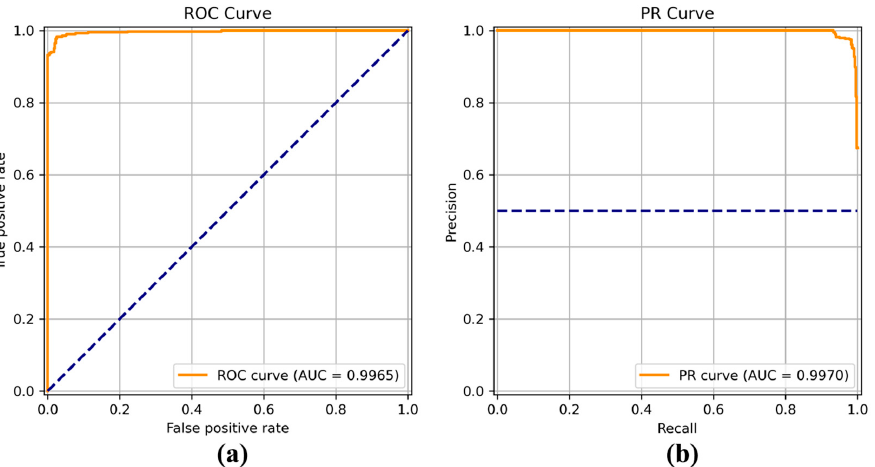
Figure 12. ( a ) Receiver operating characteristic (ROC) curve and ( b ) precision recall (PR) curve of MobileNet.